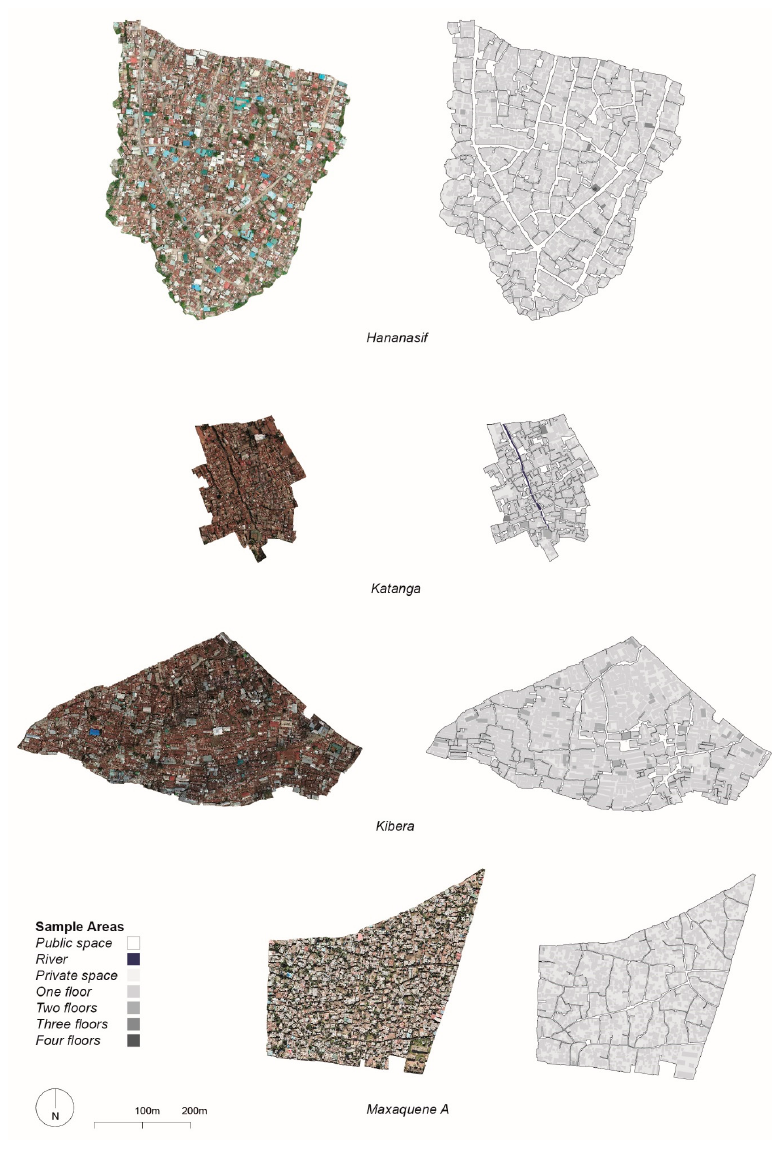
Figure 2. Orthophotos and vectorized maps of case study areas. Table 4. Indicators of urban form for the four surveyed